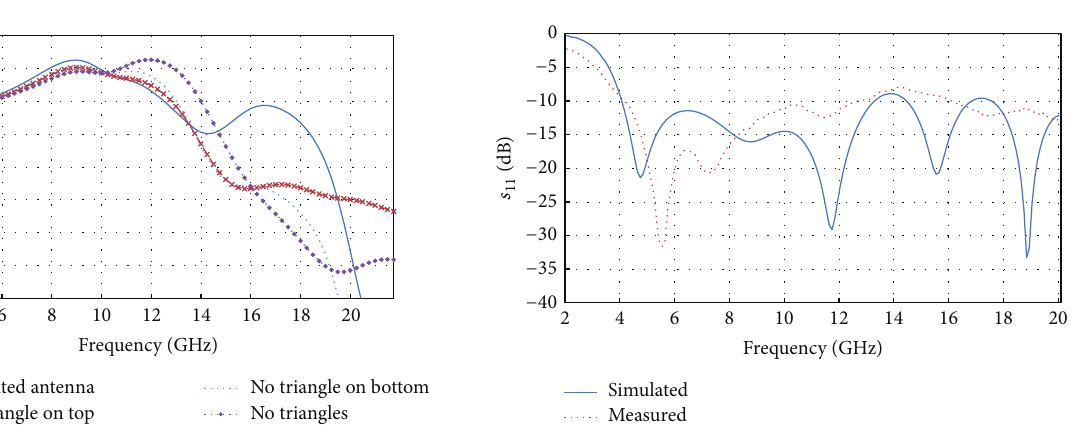
Figure 6: Comparison of simulated and measured return loss.